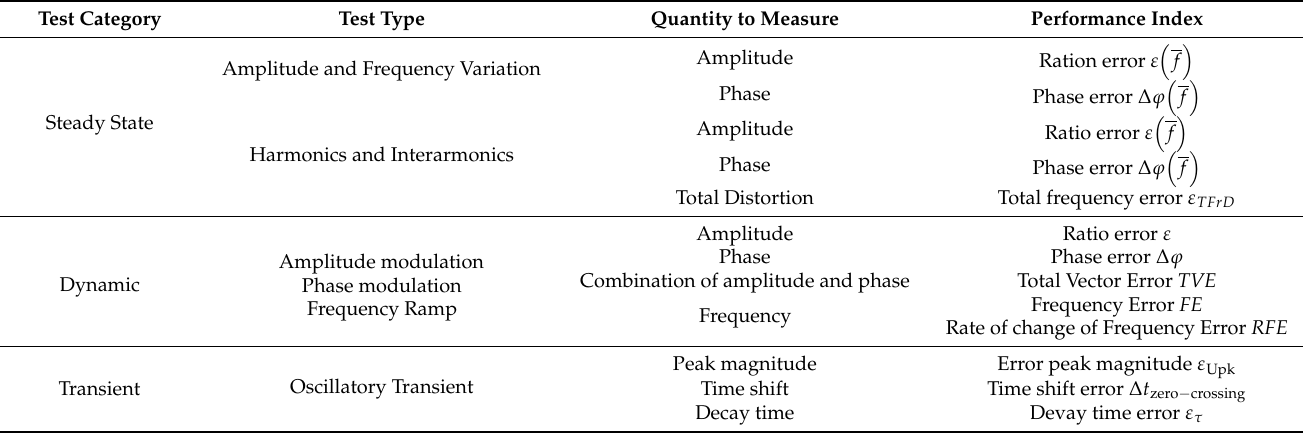
Table 2. Proposed PIs for IT characterization: a